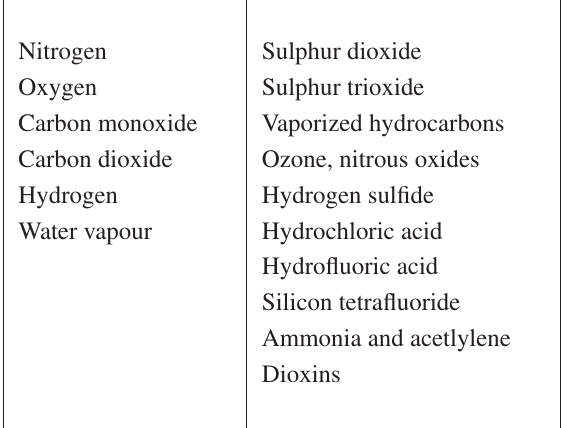
Table 1. Typical constituents present in the electric